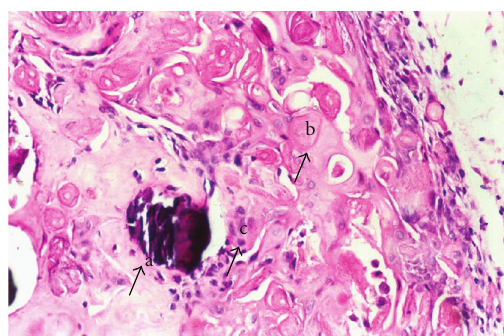
Figure 5: Irregular foci of dentine/osteo-dentine-like material (a) and calcifying ghost cells (b) and giant cells (c) [Hemataoxylin and Eosin, × 40].